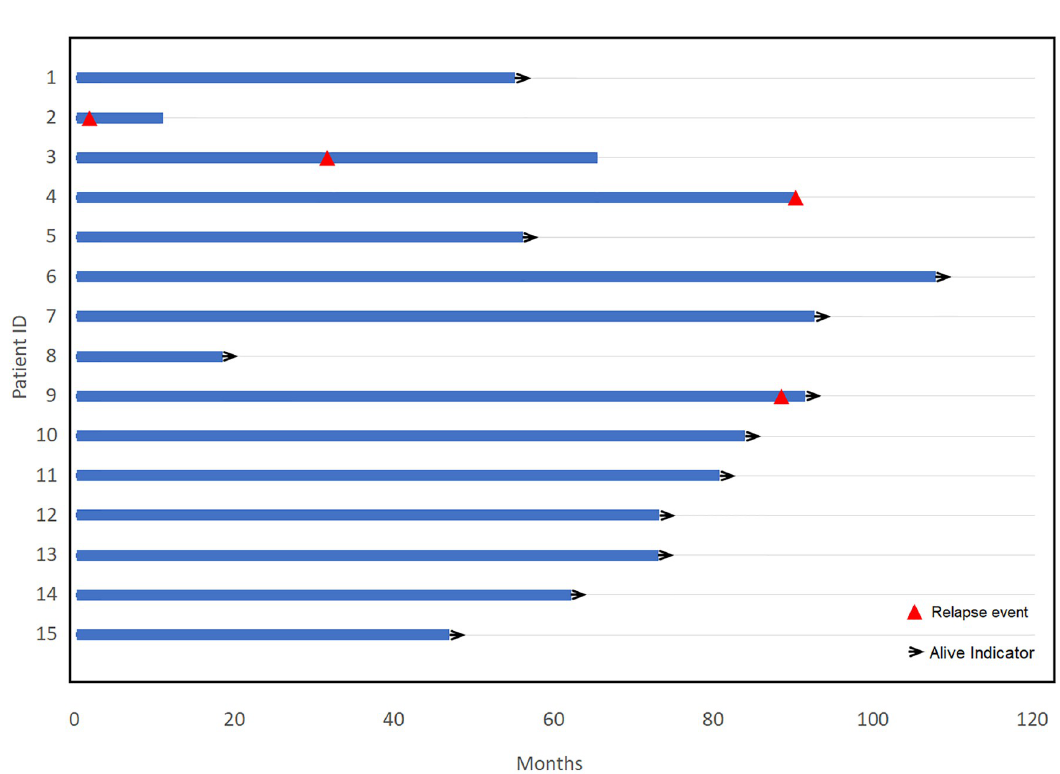
Fig 1. A swimmer plot showing the survival period of 15 people. Four people relapsed, of whom three expired. Those who relapsed are indicated by a red triangle, and those who survived are indicated by a black arrow.